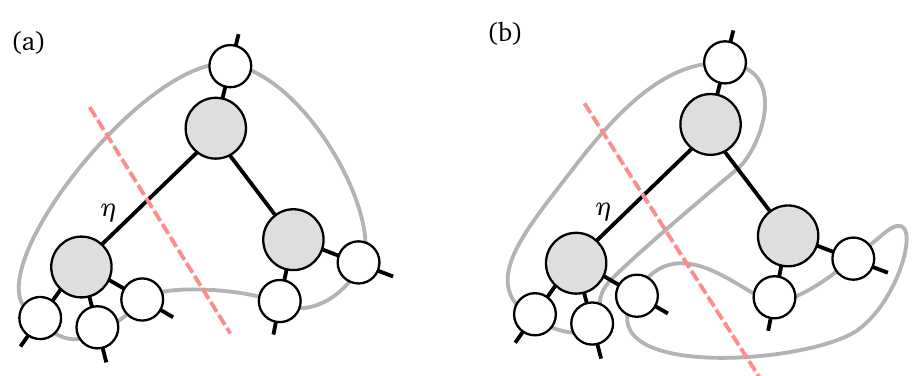
Figure 36: Two possible configurations for global TPO interactions (white tensors) acting on a TN state (gray tensors). Every local operator has two non-trivial TPO links: While the TPO configuration in (a) is considered efficient, in (b) there are four TPO links joining the network bipartition over the virtual link η (indicated by the dashed red